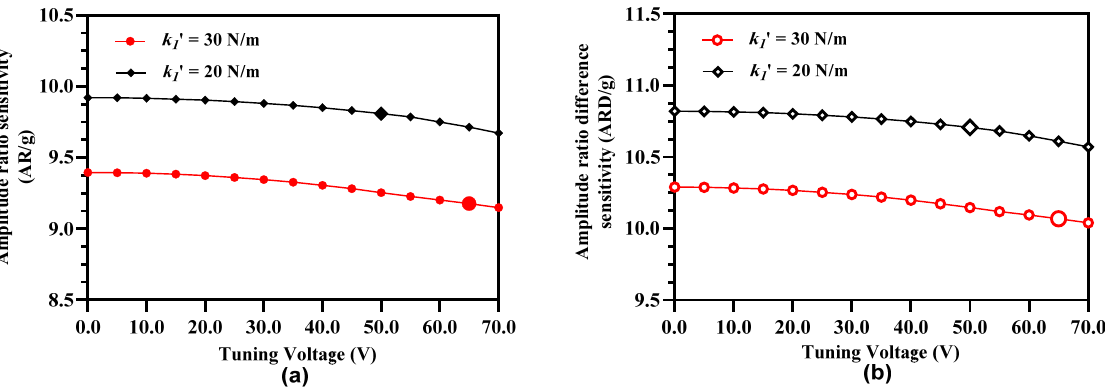
Figure 14. Effect of applying electrostatic tuning voltage to the middle resonators in 3-Dof resonator Set A and Set B with (cid:1863) (cid:2869)(cid:4593) = 30 N/m and (cid:1863) (cid:2869)(cid:4593) = 20 N/m on ( a ) amplitude ratio sensitivity and ( b ) amplitude ratio difference sensitivity.